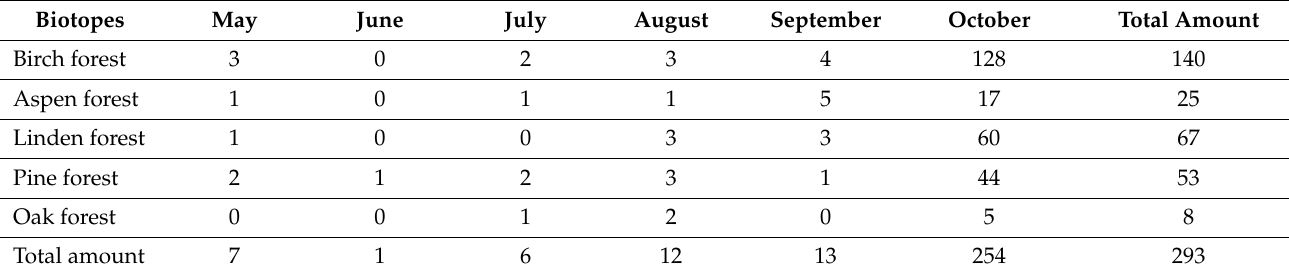
Table A5. Seasonal dynamics of Drosophila phalerata in five